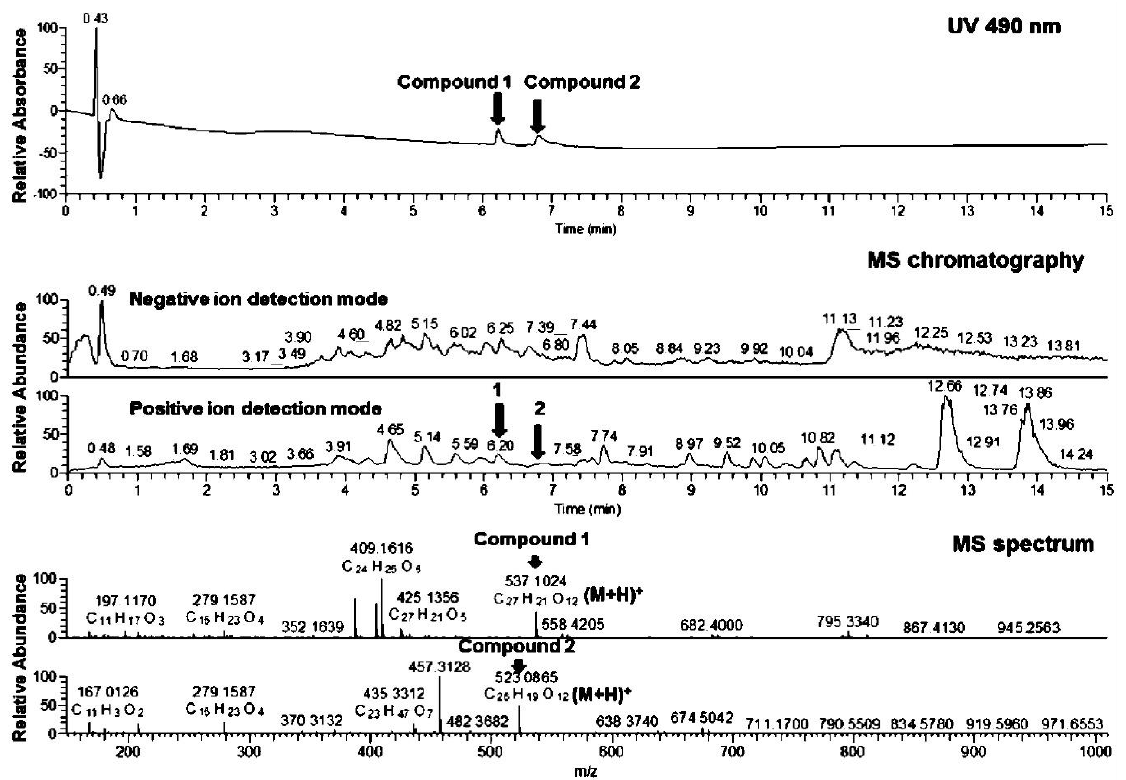
Figure 3. LC-MS analysis of the EtOAc extract from the culture broth of Streptomyces sp.